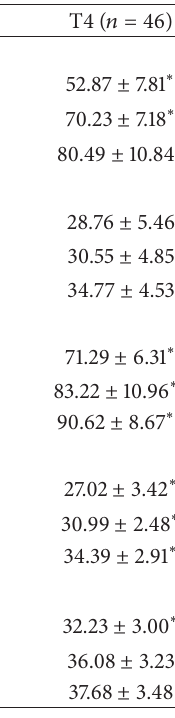
Table 1: Various anthropometric status in subjects with different weight